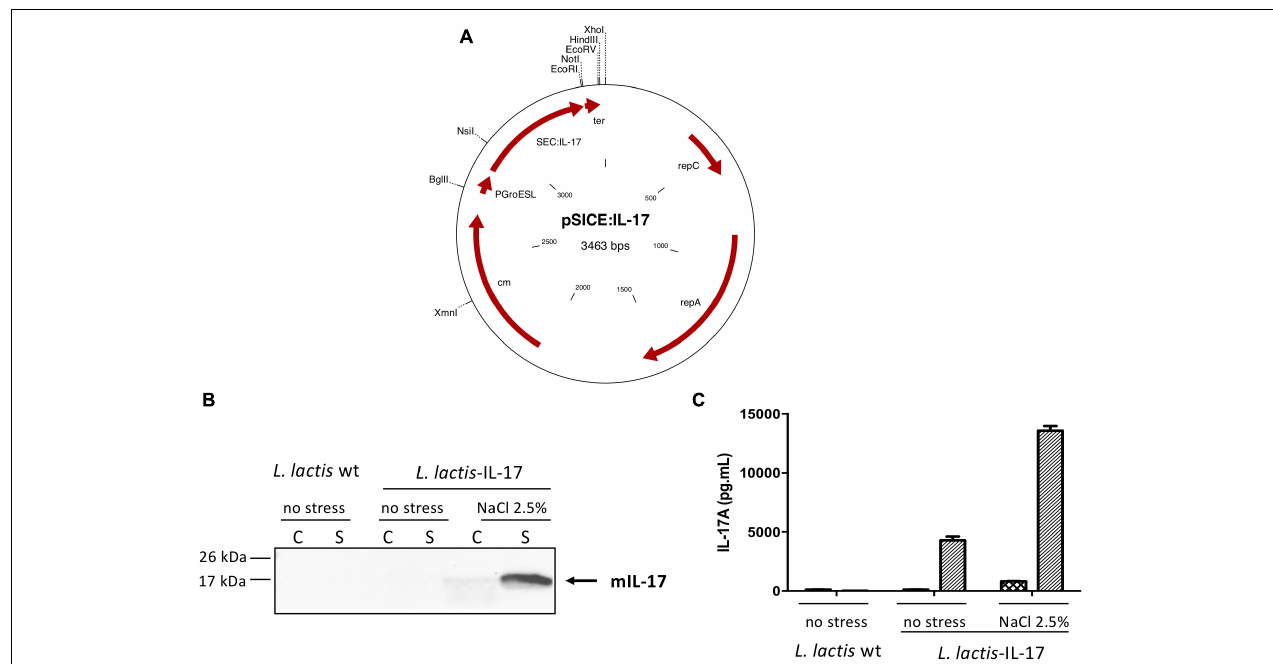
FIGURE 1 | IL-17 expression by L. lactis . (A) Schematic representation of pSICE:IL-17 plasmid. Protein samples (C and S) were prepared from both non-stressed and stressed L. lactis -wt and L. lactis -IL-17 cultures and IL-17 production was assessed by (B) Western blot and (C) ELISA. Position and size of molecular mass markers is indicated on the left. The position of mature murine IL-17 is given by an arrow. Values are mean ±